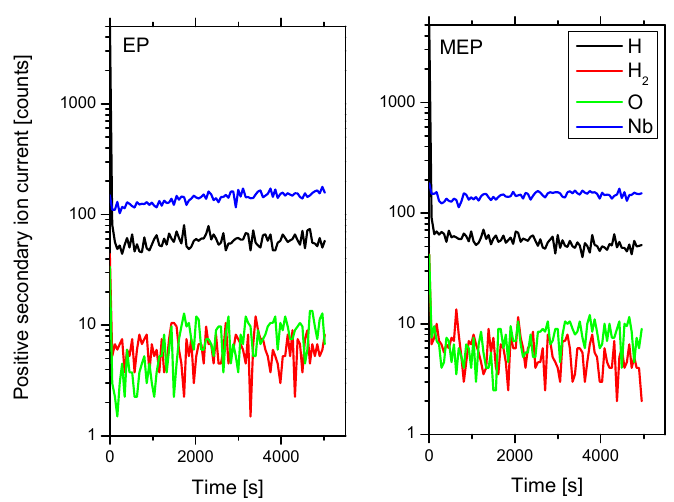
Figure 5. Rough results of SIMS profile analysis obtained in the 2nd series of measurements. The secondary ion currents are displayed. Surface area of ion etching: 1 mm × 1 mm, analysis area: 0.4 mm × 0.4 mm, two Nb samples were used for the study: EP—on the left, and MEP—on the right.